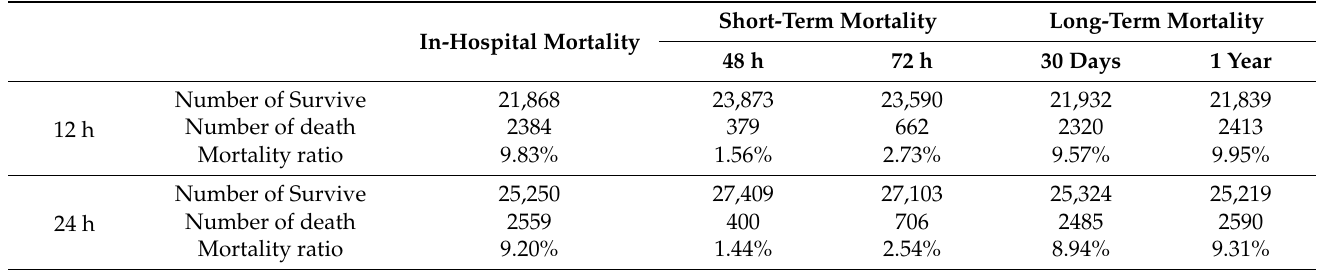
Table 3. Demographic information of the selected patient cohort.